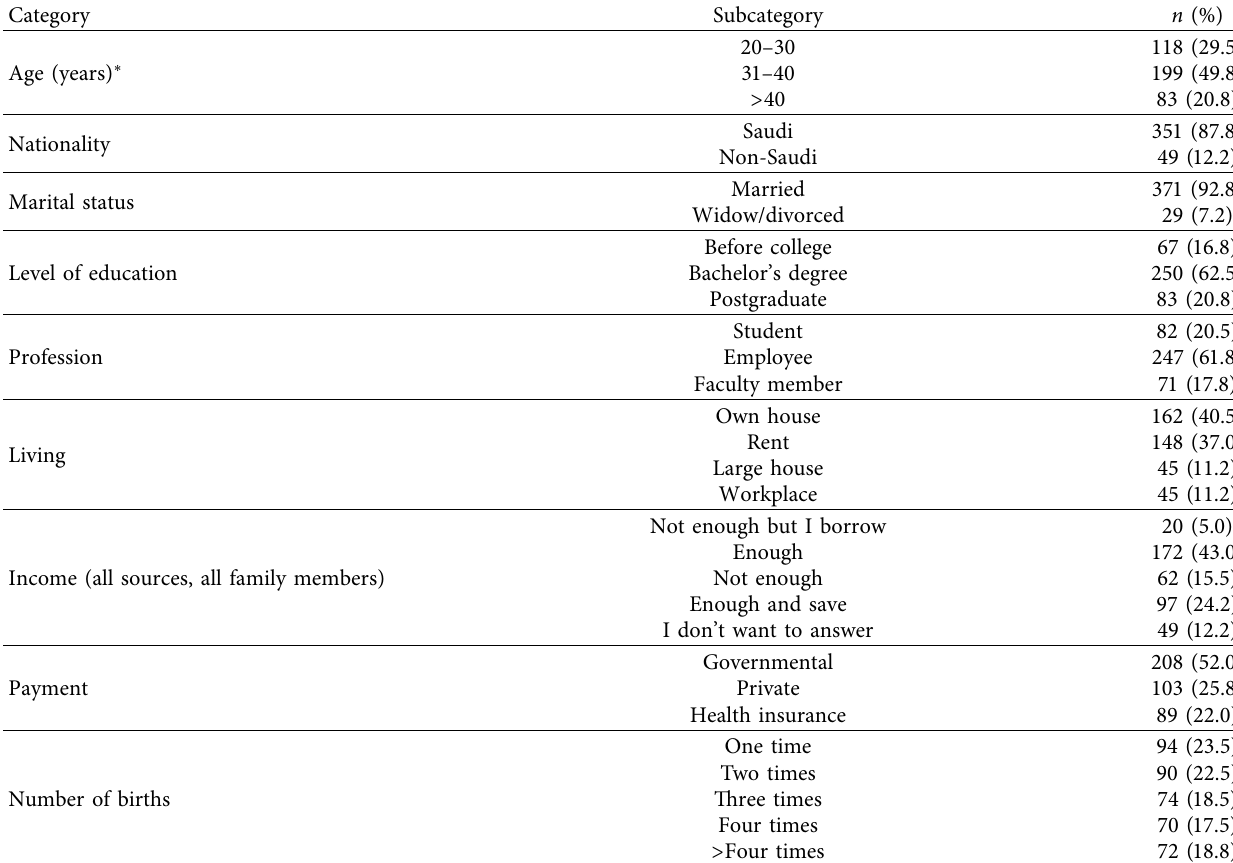
Table 1: Distribution of participants by sociodemographic characteristics ( n � 400).